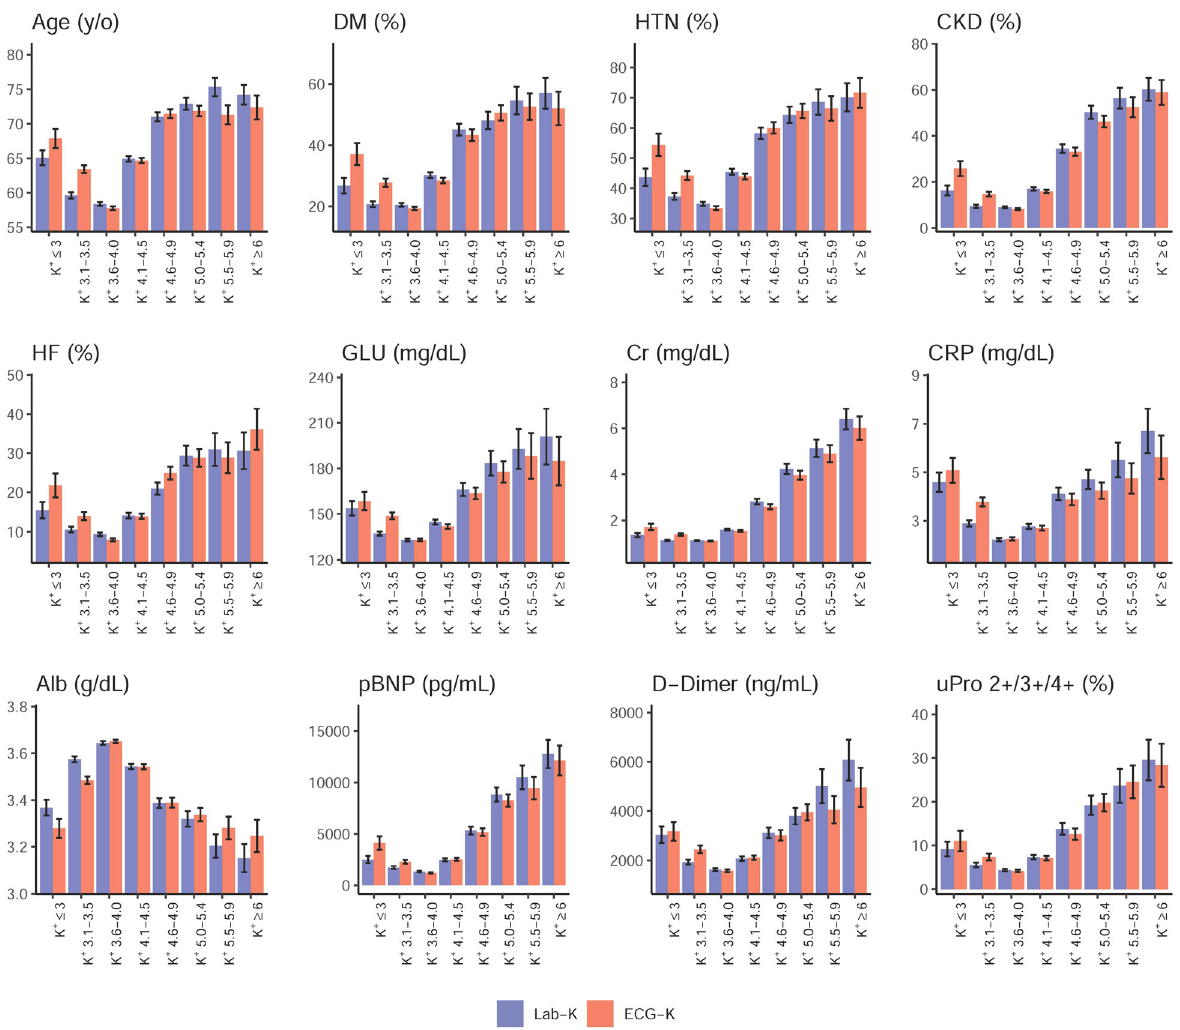
Fig. 3 Distributions of selected patients ’ characteristics in each ECG-K + and Lab-K + group. Bars represent the mean or proportion where appropriate and corresponding 95% conference intervals, which are adjusted by